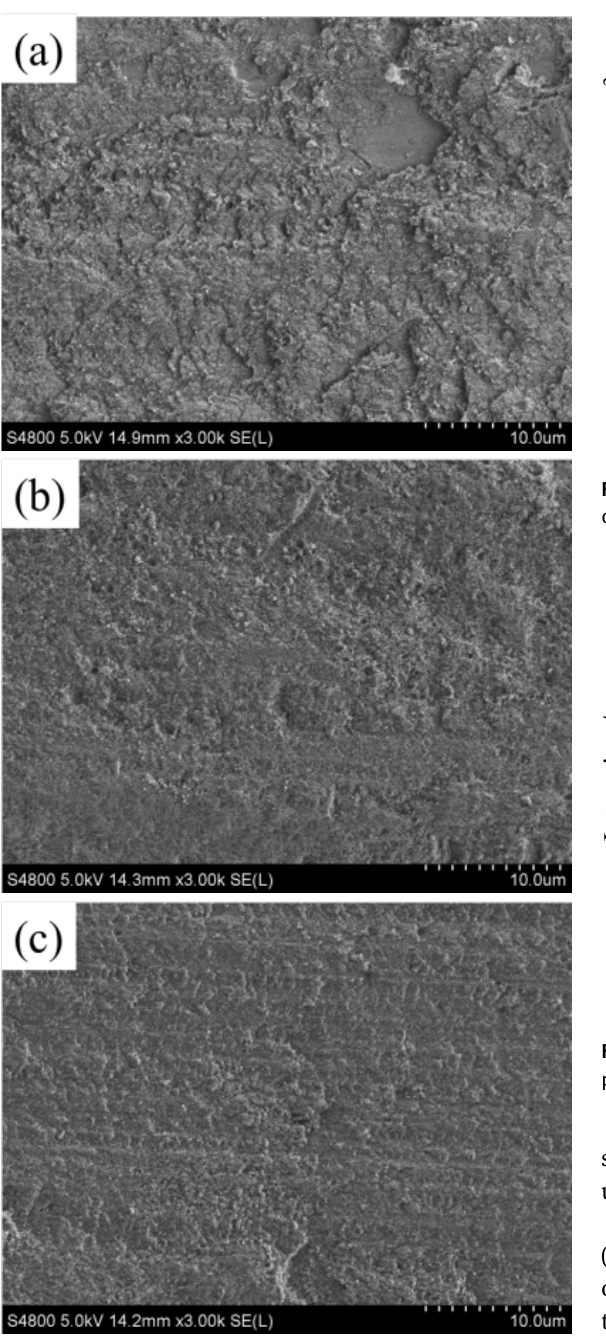
Figure 6: Worn surface of Fe-based amorphous coatings deposited under different spraying power levels (a) 30kW, (b) 35kW and (c) 40kW, respectively.